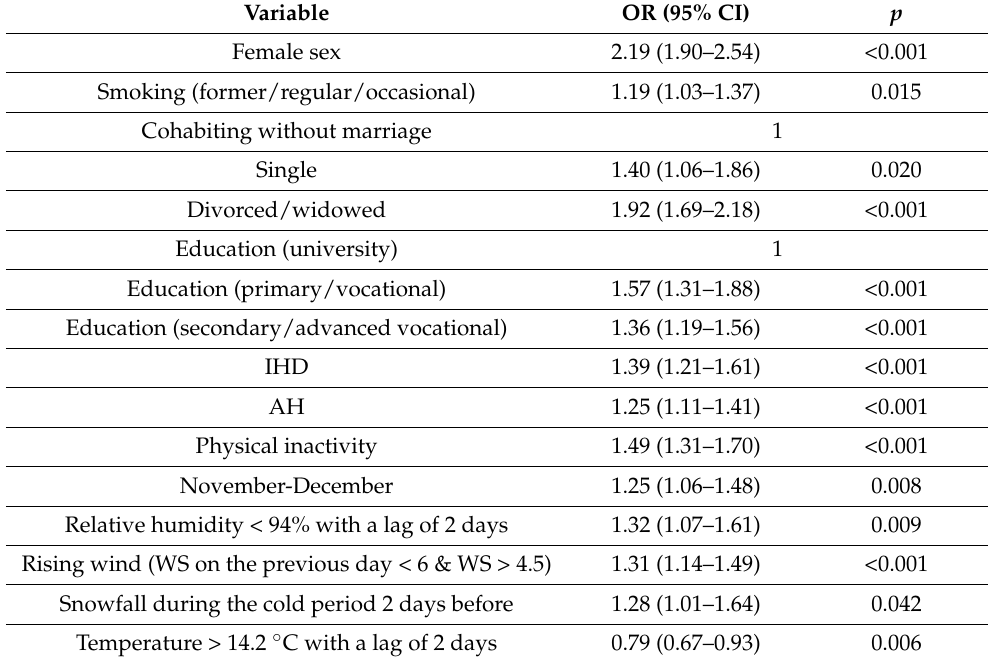
Table 2. The risk of depressive symptoms in association with some sociodemographic and lifestyle factors, illnesses, and meteorological factors, adjusting for age.